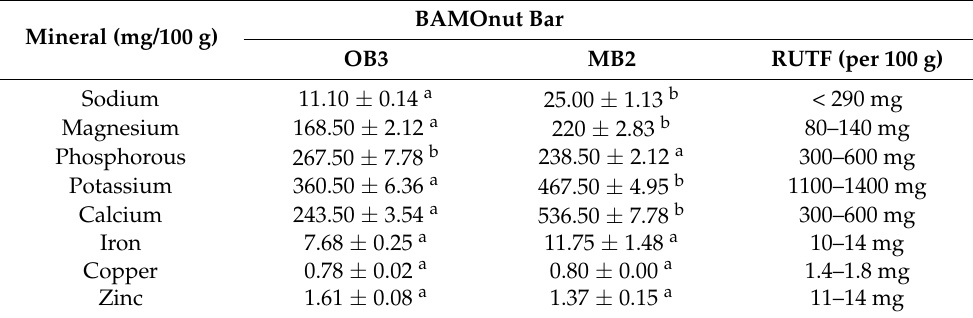
Table 8. Mineral composition of BAMOnut.